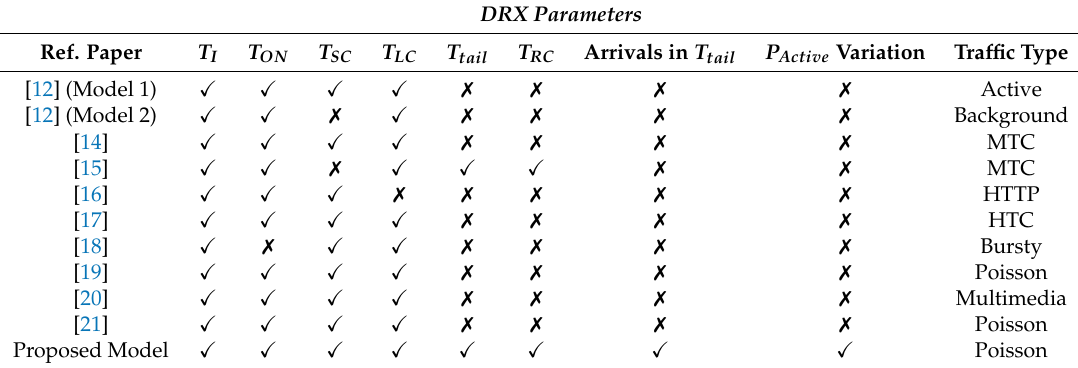
Table 2. A comparison of power consumption models based on the DRX mechanism. MTC: Machine-type communication; HTTP: HyperText Transfer Protocol; HTC: Human-type